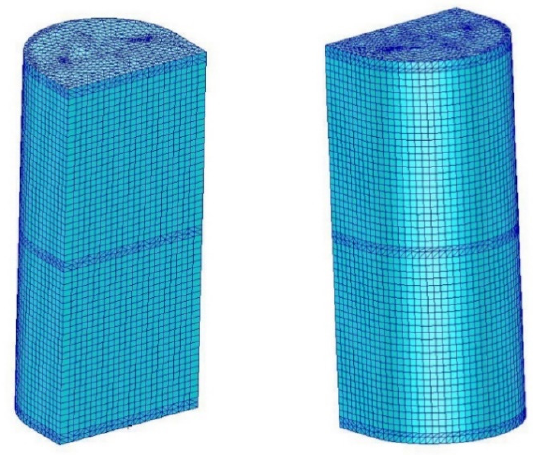
Figure 15. Finite elements mesh view.